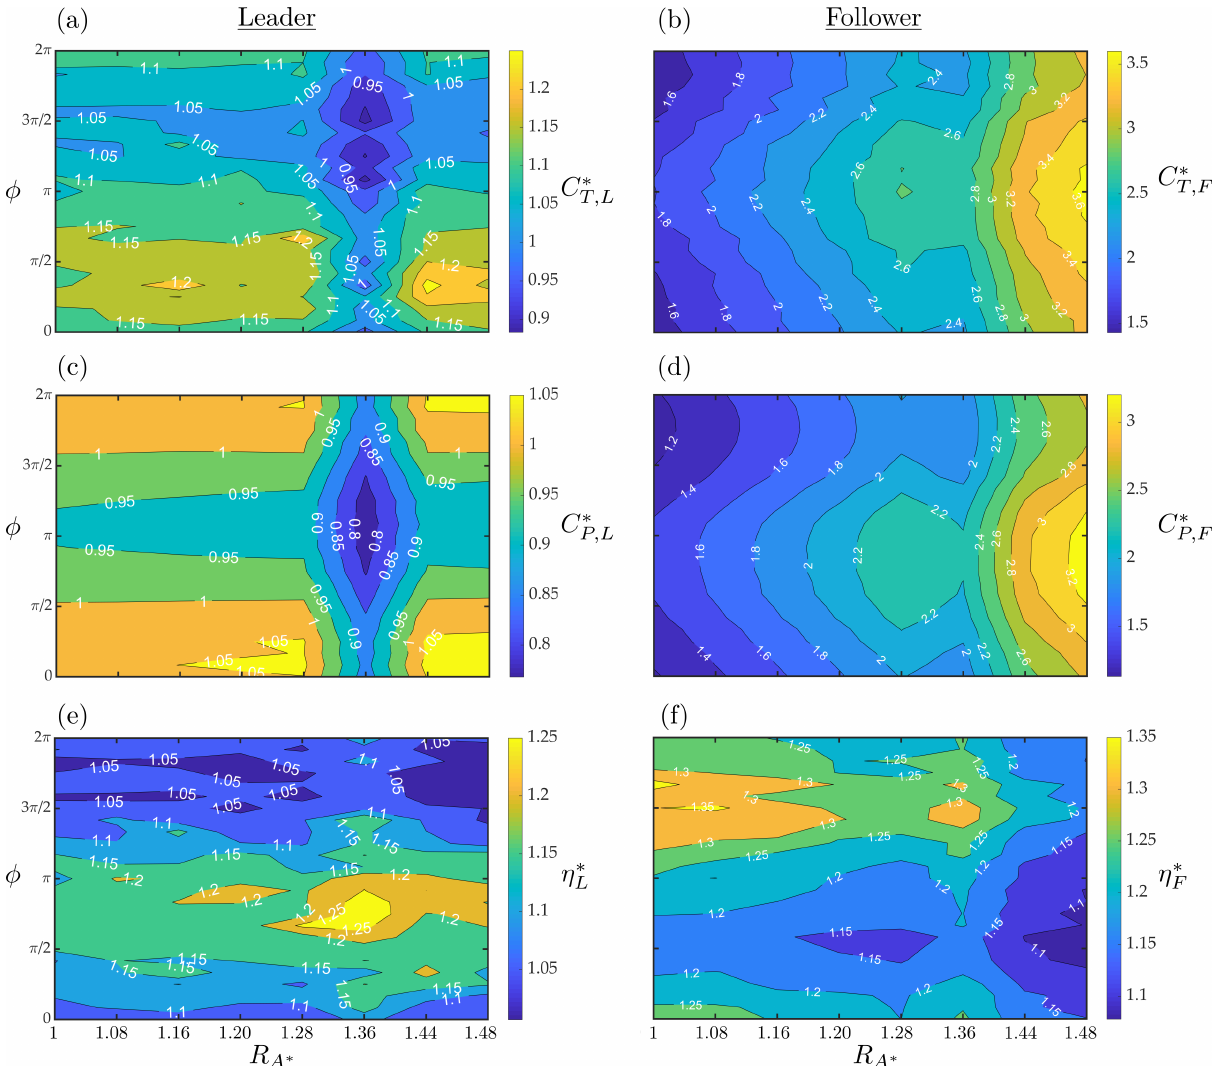
Figure A4. Normalized ( a , b ) thrust, ( c , d ) power and ( e , f ) efficiency of leader (left column) and follower (right column) foils as a function of synchrony and follower-to-leader amplitude ratio for an in-line arrangement at ( X ∗ , Y ∗ ) = ( 0.5,0 )